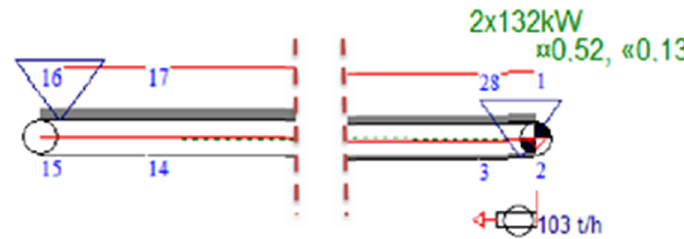
Figure 3. Conveyor route profile.